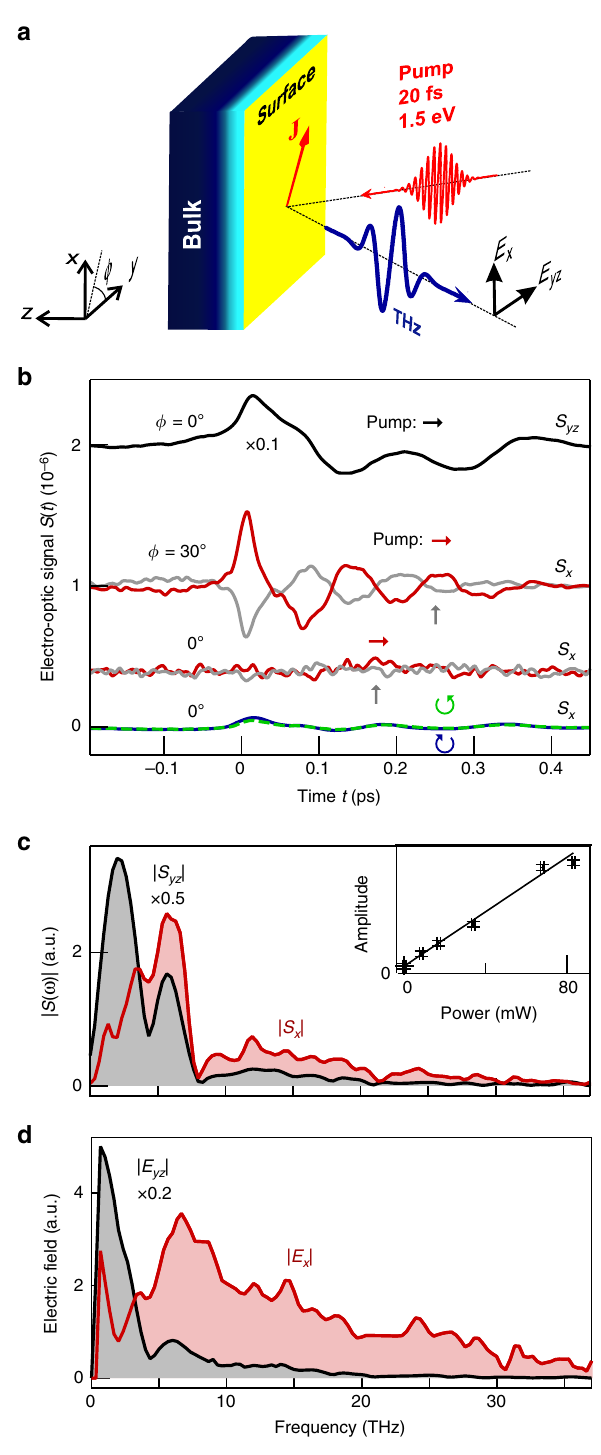
Figure 1 | THz emission experiment and raw data. ( a ) Schematic of the ultrafast photocurrent amperemeter. A Bi 2 Se 3 crystal is excited by a femtosecond laser pulse, resulting in a photocurrent burst and, consequently, emission of a THz electromagnetic pulse. Measurement of the transient THz electric field components E x ( t ) and E yz ( t ) by electro-optic sampling provides access to the sheet current J ( t ) flowing inside the sample. ( b ) Typical x - and yz -polarized THz electro-optic signals S x and S yz measured for various settings of pump polarization and sample azimuth f . The signals are offset for clarity. ( c ) Amplitude spectra of the THz signal and ( d ) THz electric field directly behind the sample as extracted from b . NATURE COMMUNICATIONS|7:13259|DOI: